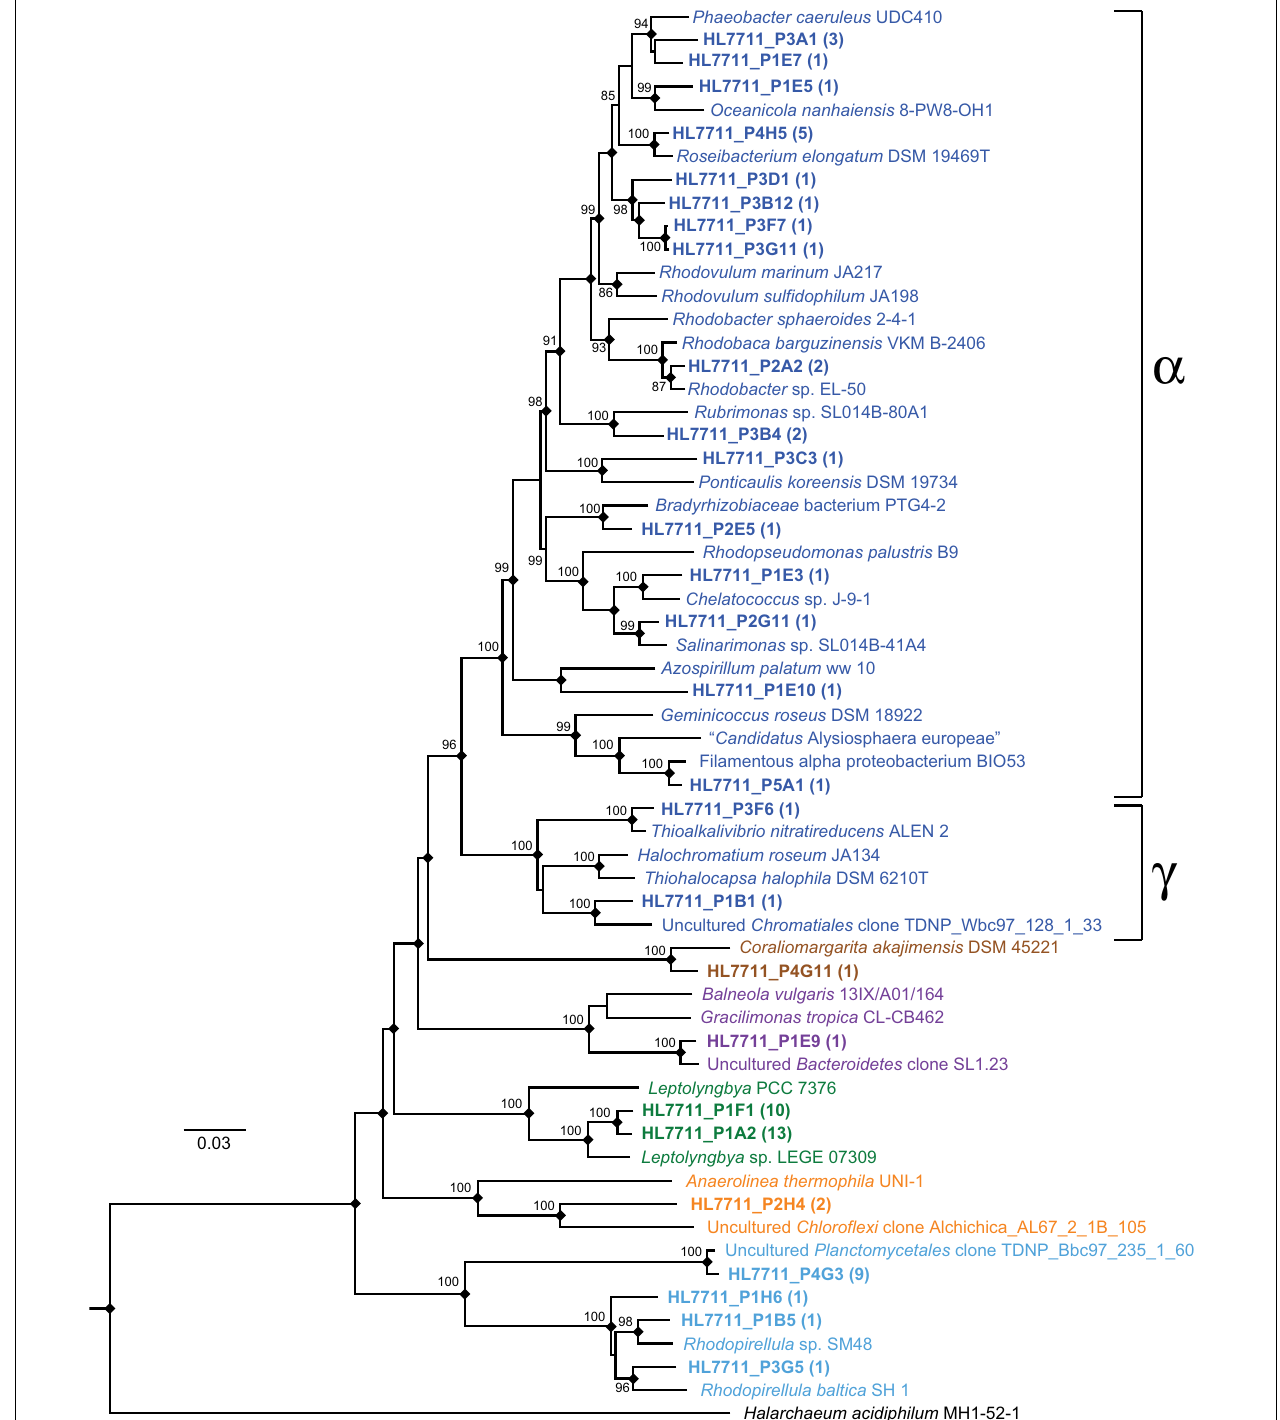
FIGURE 9 | Phylogenetic reconstruction of near full-length 16S sequences from the Hot Lake mat representing major OTUs. Clones were generated from mat sampled on July 7, 2011 and are in bold. Clusters of sequences with > 99% identity are represented by a single sequence; the number of sequences represented by each is noted parenthetically. While a neighbor-joining tree is depicted above, nodes